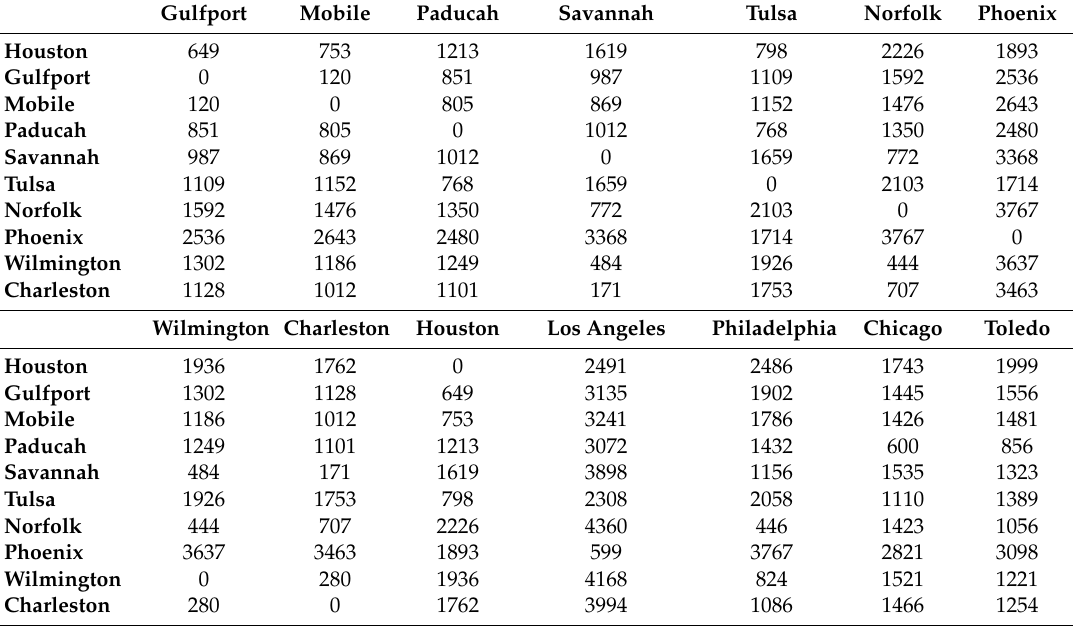
Table A3. Road distances between Port and Extraction locations (km).